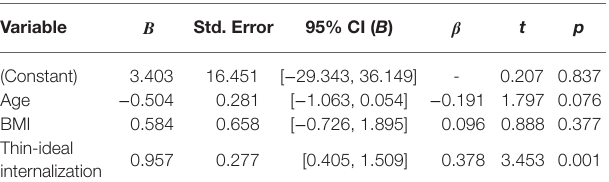
TABLE 1 | Simple linear regression with thin-ideal internalization predicting disordered eating behaviors. Variable